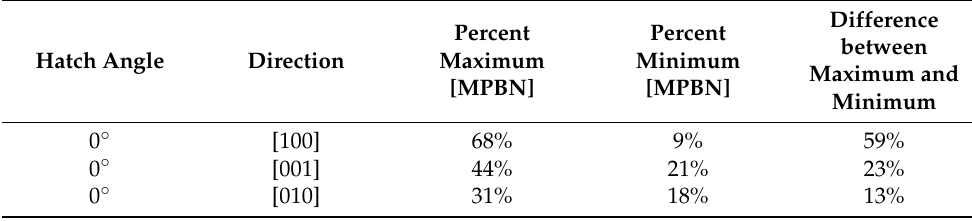
Table 4. The maximum, minimum, and difference between the pseudo-sinusoidal peaks for the three directions of interest.